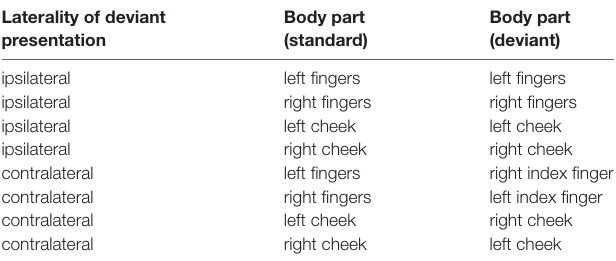
TABLE 1 | Experimental setup and spots where the stimuli were